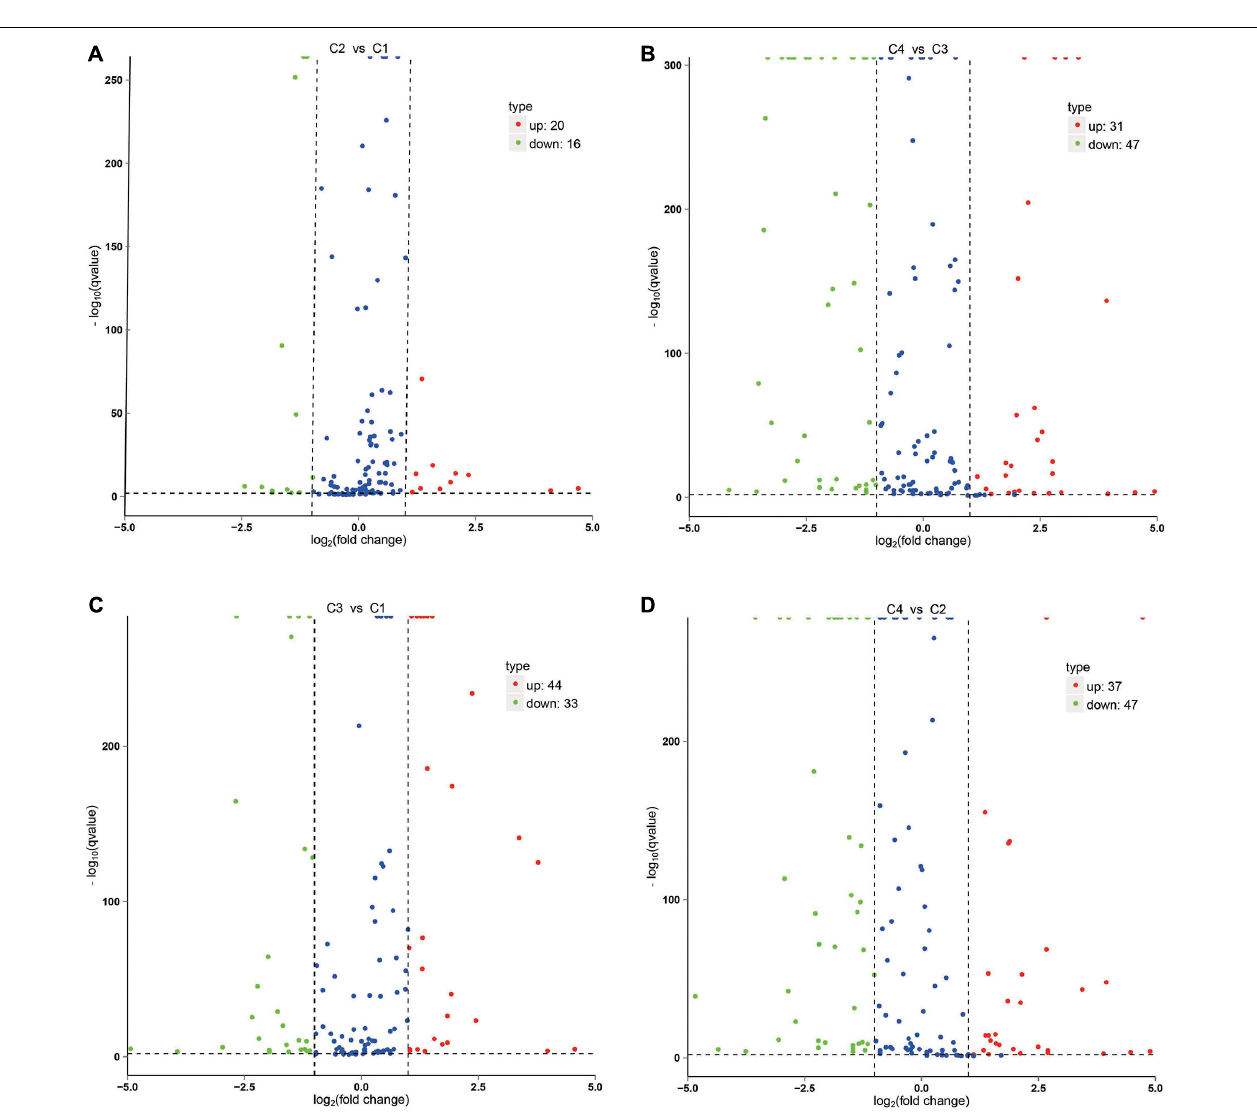
FIGURE 12 | Volcano plot of differential miRNA. (A) Differential miRNA from C2 vs. C1. (B) Differential miRNA from C4 vs. C3. (C) Differential miRNA from C3 vs. C1. (D) Differential miRNA from C4 vs. C2. X -axis, miRNA expression fold change in different experimental groups/different control groups; Y -axis, statistical significance of the change in the expression level of miRNA. Red dots indicate significantly differential upregulated miRNAs, green dots indicate significantly differential downregulated miRNAs, and blue dots indicate those without significantly differential miRNAs. C1: BcL.1-25 , C2: BcL.1-4 , C3: BcL.2-25 , C4: BcL.2-4